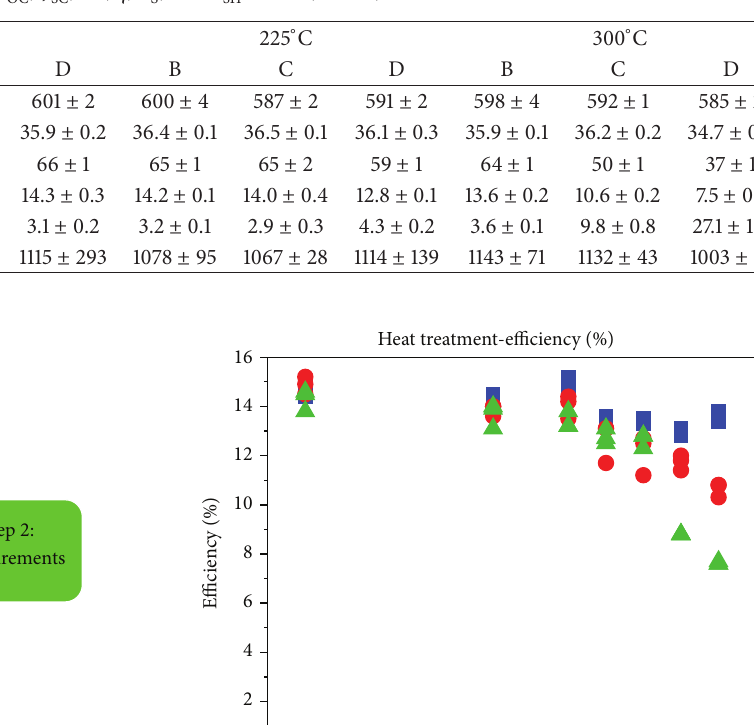
Table 2: Values of 𝑉 OC , 𝐽 SC , 𝐹𝐹 , 𝜂 , 𝑅 𝑆 , and 𝑅 SH at 25 ∘ C, 225 ∘ C, and 300 ∘ C.